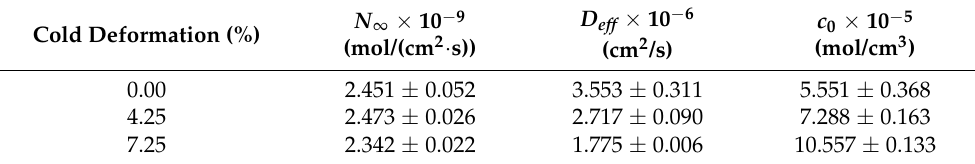
Table 2. Parameters from the first hydrogen permeation curves of X65 pipeline steel with different cold deformation levels.